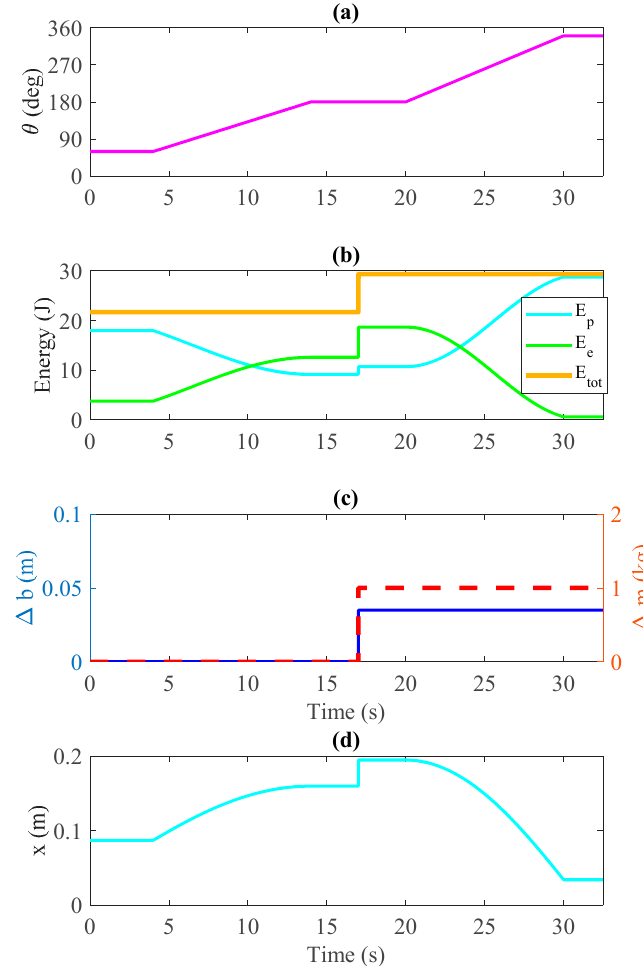
Figure 5. Results of the simulation: ( a ) link configuration; ( b ) potential energy, elastic energy and total energy; ( c ) variation ∆ b and payload ∆ m ; ( d ) spring length x .